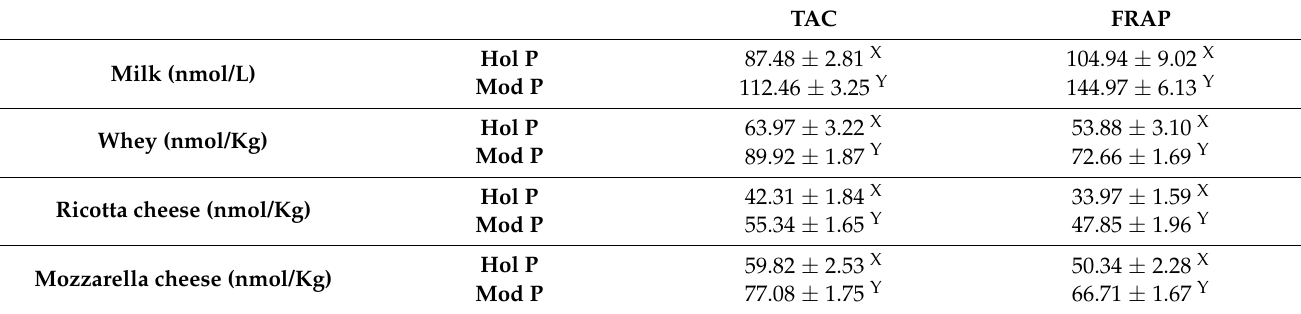
Table 2. Effect of breed on antioxidant activity in milk and dairy products. The pairwise contrast involved Holstein (Hol) and Modicana (Mod) breeds fed pasture